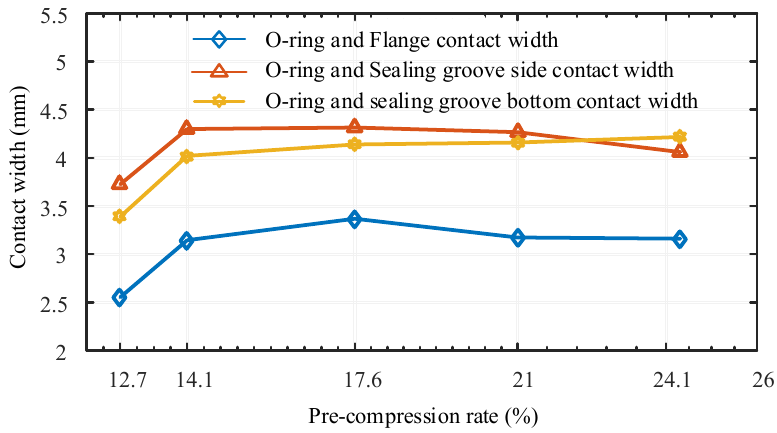
Figure 20. Contact width affected by pre-compression ratio.